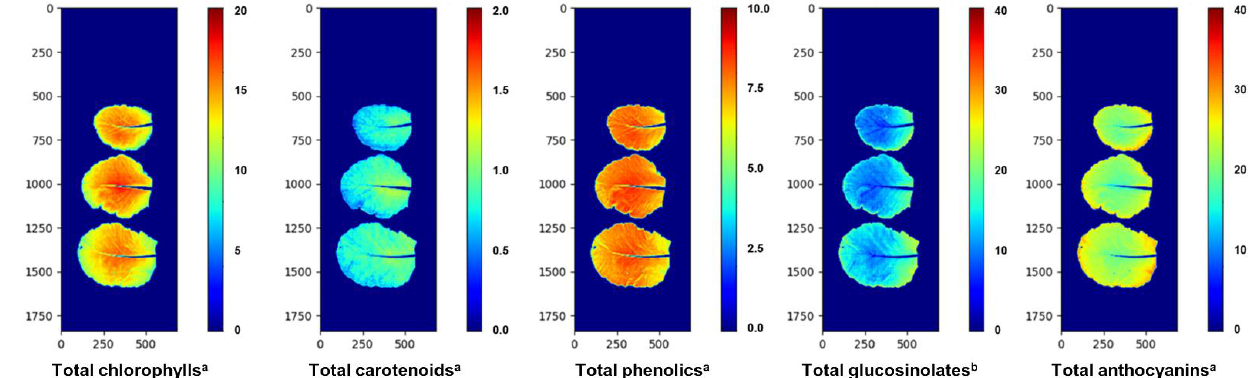
Figure 6. Distribution maps of plant functional components predicted by the developed PLSR models. X - and Y -axes indicate the size of images in pixels. Color bar means the predicted value of functional component by the developed PLSR model (units of measurement, a : mg g − 1 DW; b : µ mol g − 1 DW).